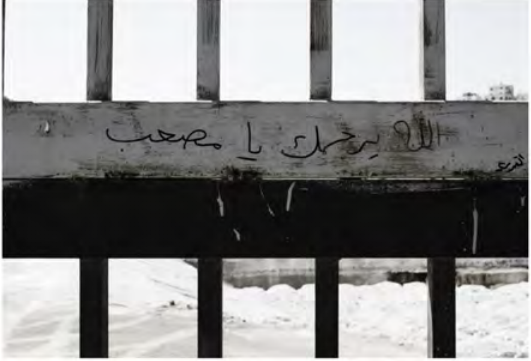
Figure 17. May your soul rest in peace Mus’ab, Sanaya Amman (Limitless towers) project. Source: The Living Voids thesis.